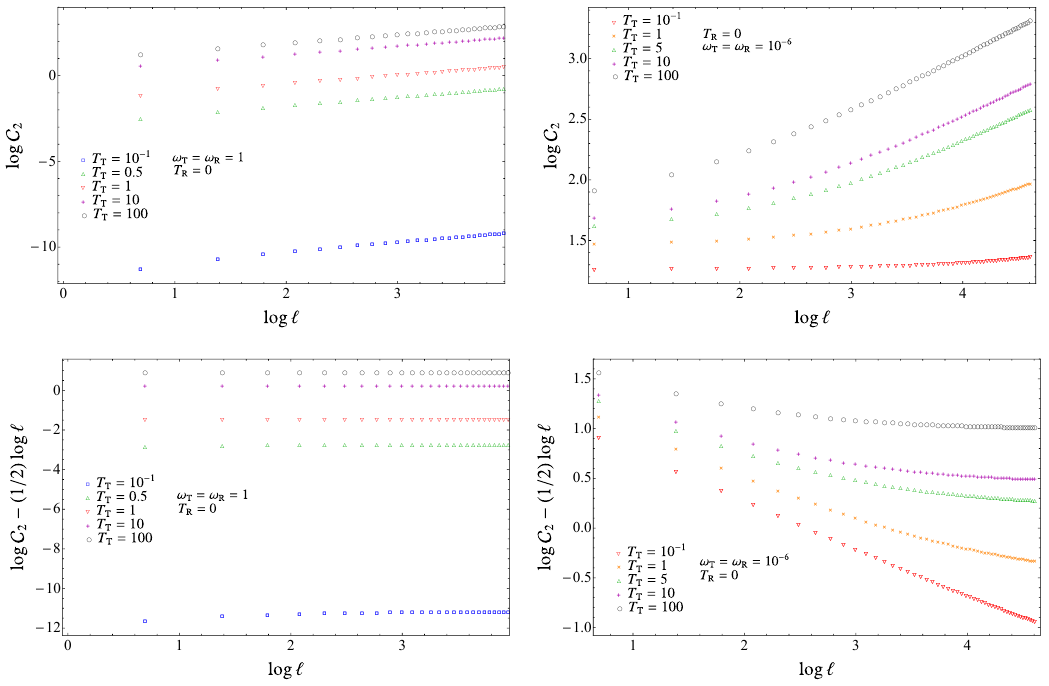
Figure 10 . Subregion complexity C 2 for an interval made by ‘ sites in an infinite harmonic chain as function of ‘ . The infinite harmonic chain is in a thermal state and T 6 = T . Here κ = m = 1 ; R T hence ˜ ω = ω , ˜ ω = ω , ˜ T = T and ˜ T = T . We fix T = 0 , considering various values R R T T R R T T R for T . We set ω = ω = 1 in the left panels and ω = ω = 10 − 6 in the right panels. The T T R T R subregion complexity C 2 is reported in the top panels, while its subleading term is studied in the bottom